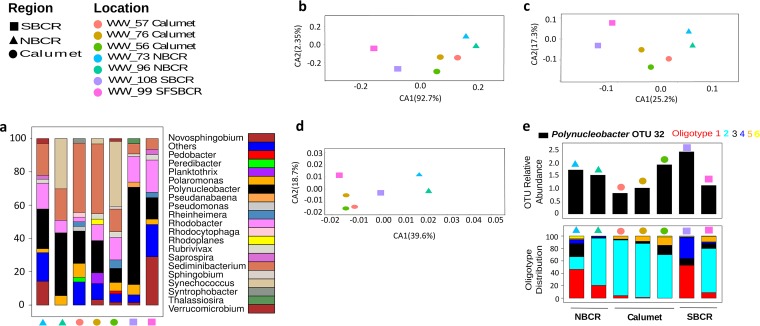
Taxonomic characterization and ordination at the OTU and sub-OTU levels between groups. (a) Genus-level differential abundance analysis (ANOVA, P < 0.001) between groups. (b) Unweighted UniFrac distance beta diversity analysis of 16S rRNA OTUs (97%). (c) Unweighted UniFrac distances for just the Polynucleobacter taxa (n = 70; 16S rRNA V4; 97% OTUs). (d) Phylogeny independent ordination of Bray-Curtis dissimilarity for just Polynucleobacter oligotypes (n = 6). (e) Relative abundance of Polynucleobacter OTU32 (top), which was significantly different between regions, and oligotype distribution of Polynucleobacter OTU32 (bottom) across the three regions. Different symbols and colors represent WRP and sampling locations, respectively.